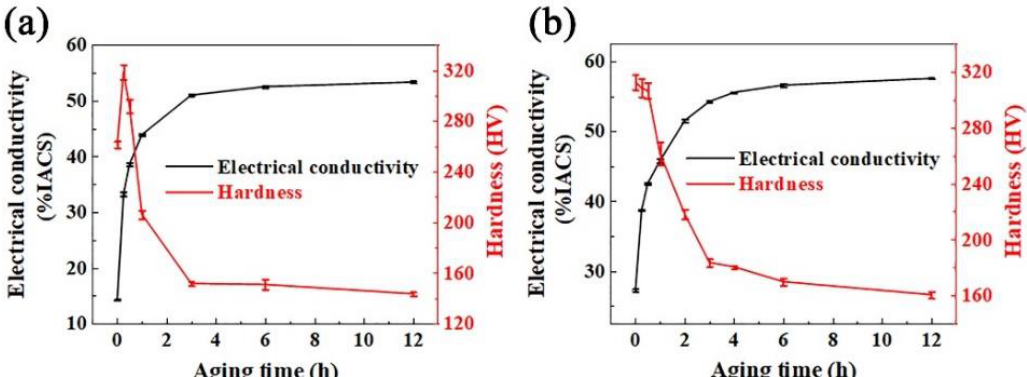
Figure 2. The variation of hardness and electrical conductivity with increasing aging time, ( a ) the first step (500 °C) and ( b ) the second step (450 °C) of aging treatment. first step (500 ◦ C) and ( b ) the second step (450 ◦ C) of aging